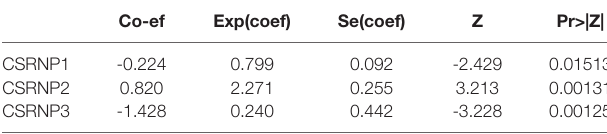
TABLE 1 | Cox proportional hazard regression analysis result shows the coef fi cient of CSRNP